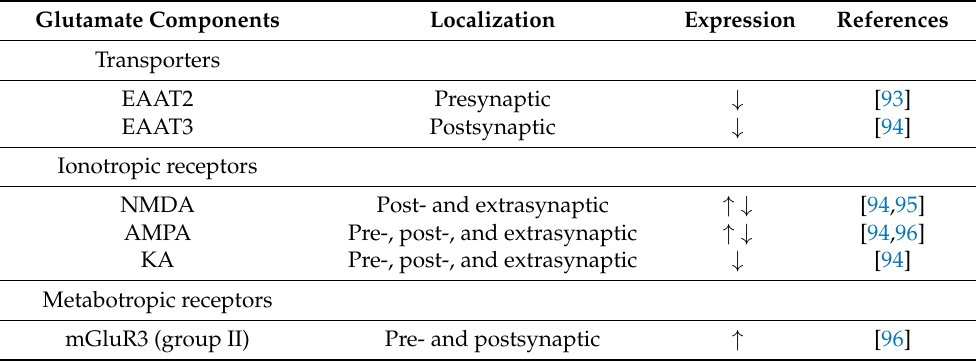
Table 1. Alterations of glutamatergic system components in human